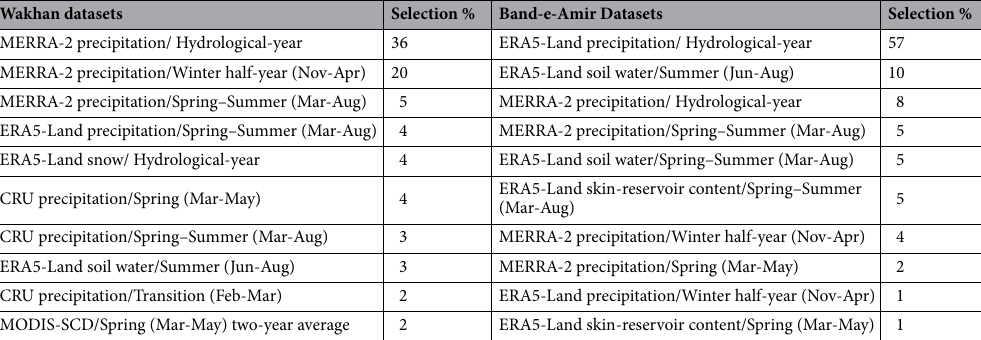
Table 3. Percentage of the 10 most frequently selected climate variables averaged over all repetitions and folds (n = 300) according to the single stepwise forward